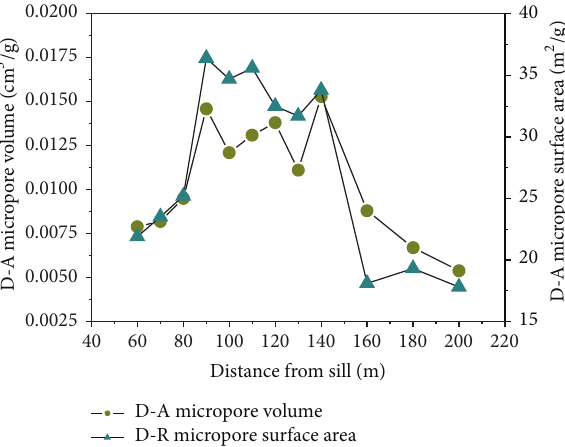
Figure 5: Relation between VM (a) and ash (b) of coal and distance from the sill.